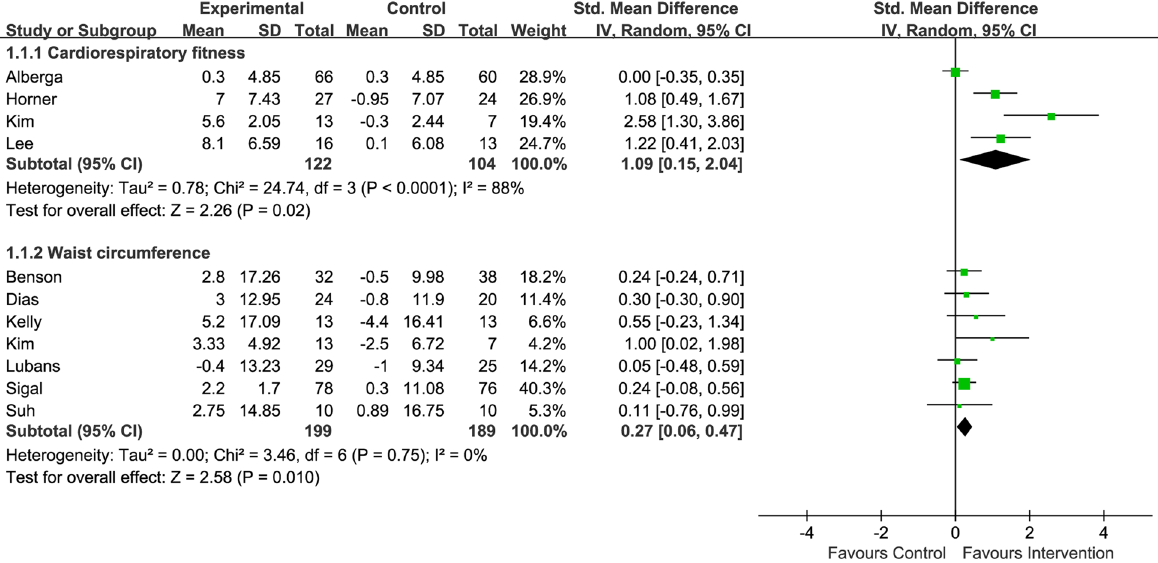
Fig. 1 Forest plot of comparison for cardiorespiratory fitness and waist